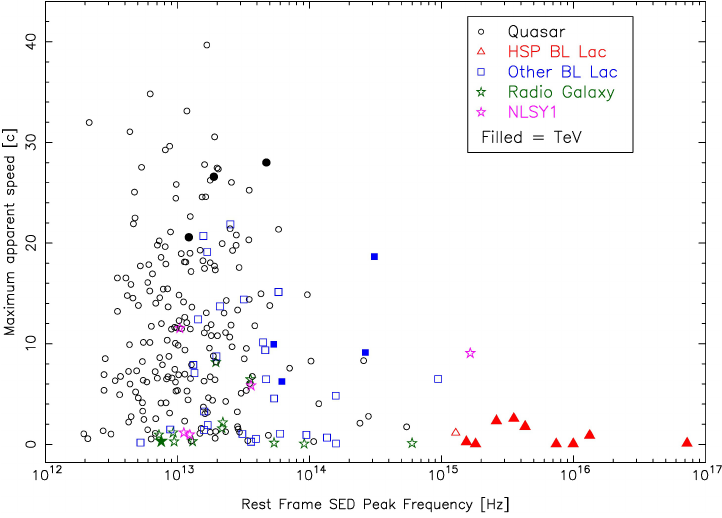
Figure 4. Plot of maximum apparent jet speed vs. synchrotron spectral energy distributions (SED) peak frequency for jets measured by the MOJAVE